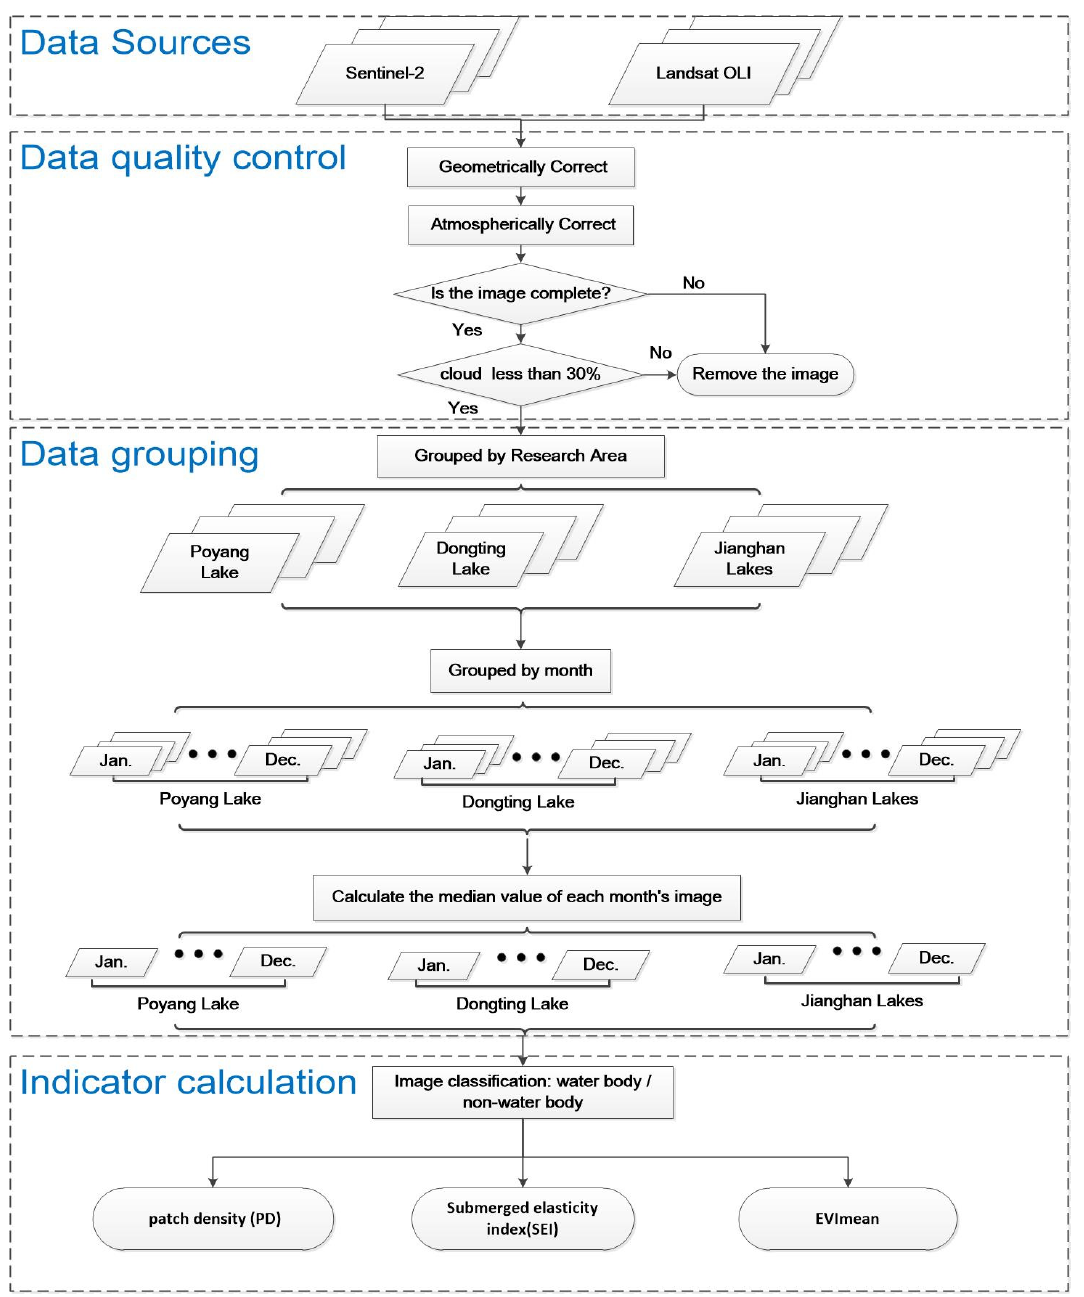
Figure 2. Workflow of the data processing of Sentinel-2 and Landsat Operational Land Imager (OLI) time-series images in the Google Earth Engine (GEE)